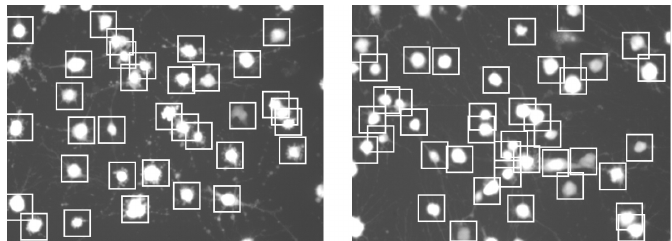
Figure 7. Outcome of the cell segmentation step. Detected cells are outlined in square segments of 50 × 50